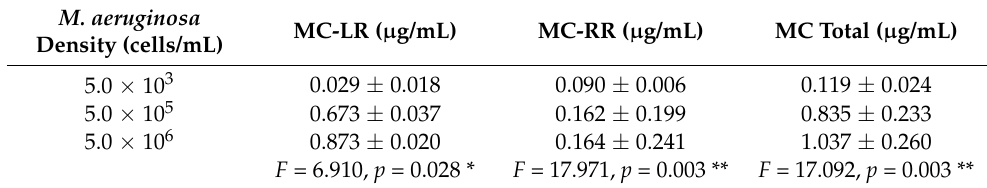
Table 2. ANOVA test and MC contents among different densities of M. aeruginosa . M. aeruginosa Density